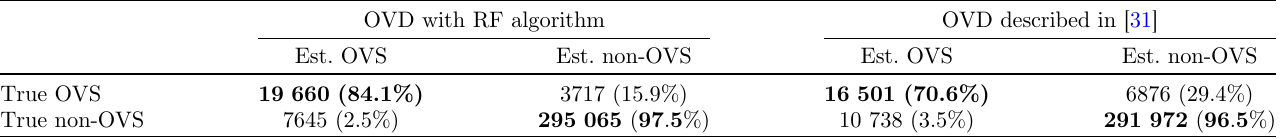
Table 1. Detected OVS for real-world recordings of one person. In total, 326 087 intervals with a duration of 125 ms were classi fi ed. The manual labels are denoted as “ True ” . OVS detected with the RF algorithm and with the algorithm described in [31] are denoted as “ Estimated ” (Est.).